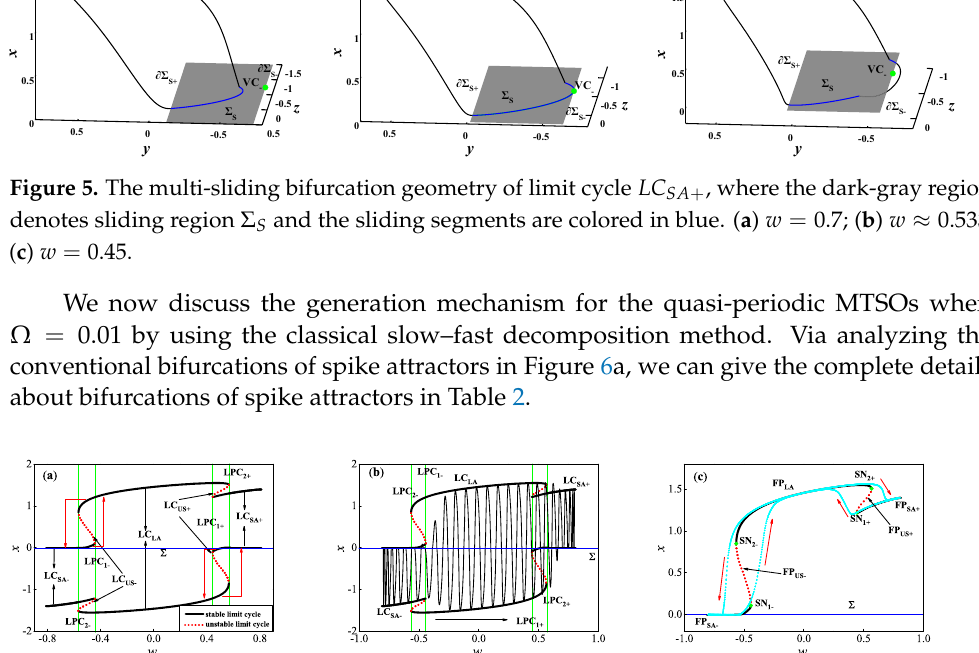
] ( n ∈ N ∗ ); ( c ) the , 5 π + 4 n π 2 Ω 2 Ω